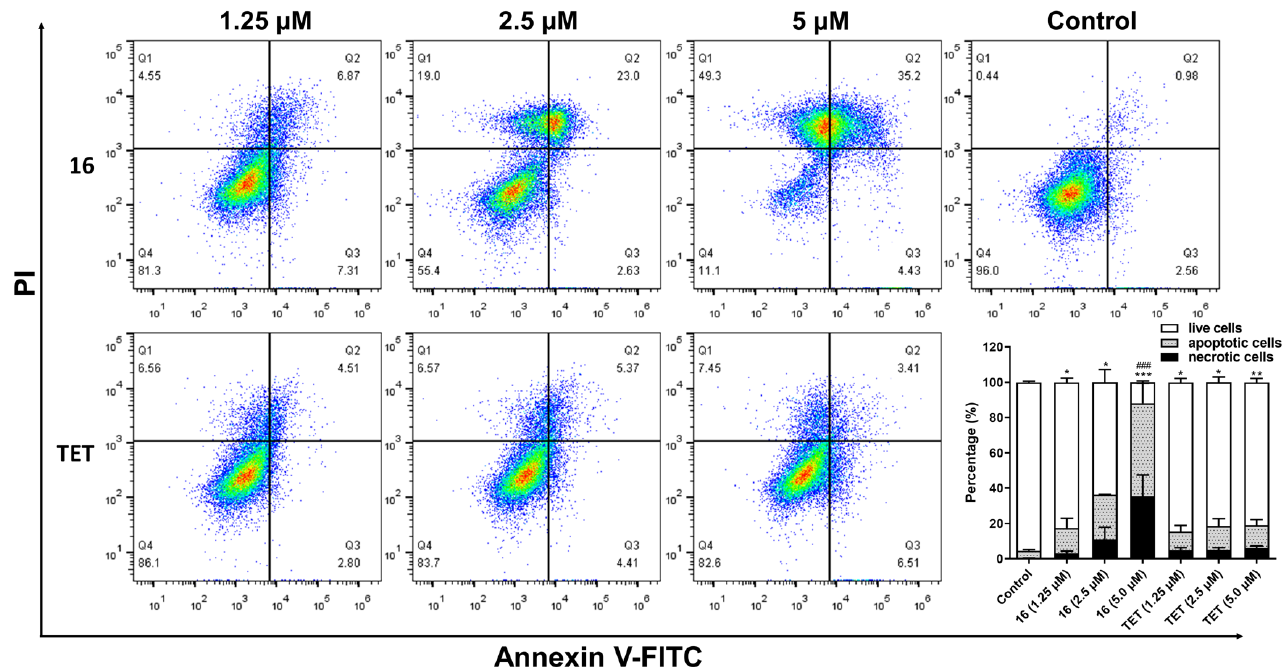
Figure 8. Flow cytometry analysis of apoptosis induction of 16 (1.25, 2.5, and 5 μ M) in HCT-15 cells. Statistical analysis of the apoptosis is depicted in the bottom right panel. *: p < 0.05, **: p < 0.01, ***: p < 0.001 vs. control; ### : p < 0.001 vs. TET at the same concentration.